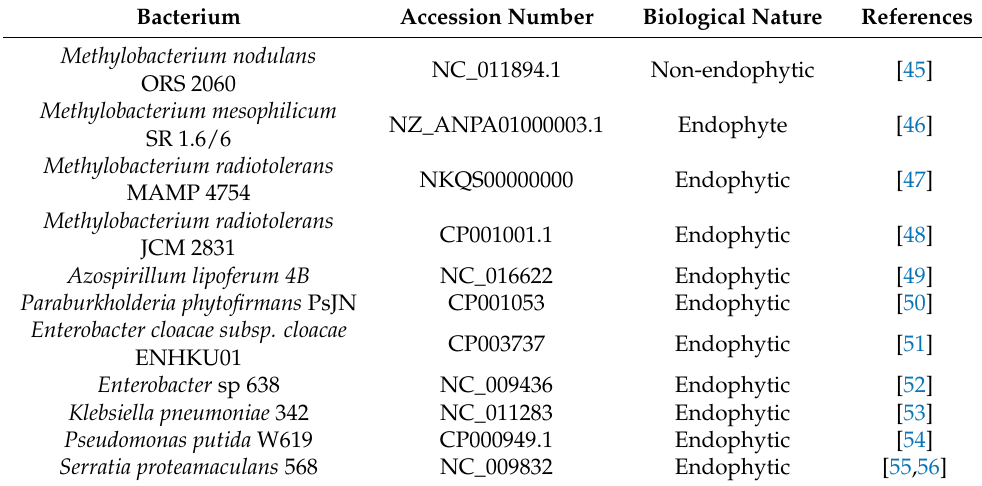
Table 1. Bacteria used in this study, including Genbank accession number and the nature of their interaction with